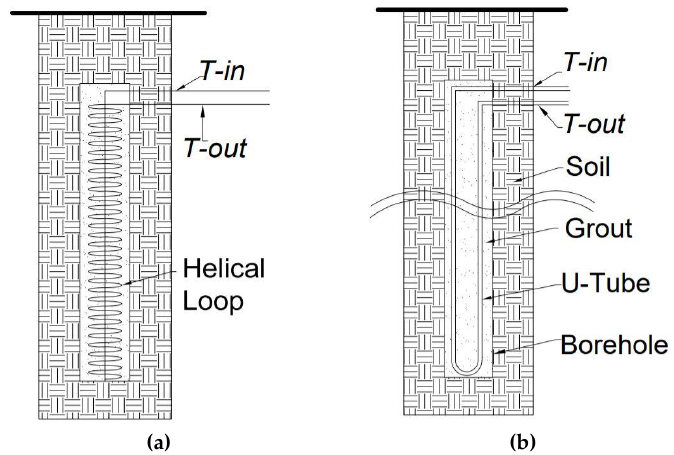
Figure 4. Vertical heat exchangers for ( a ) helical loop ( b ) conventional